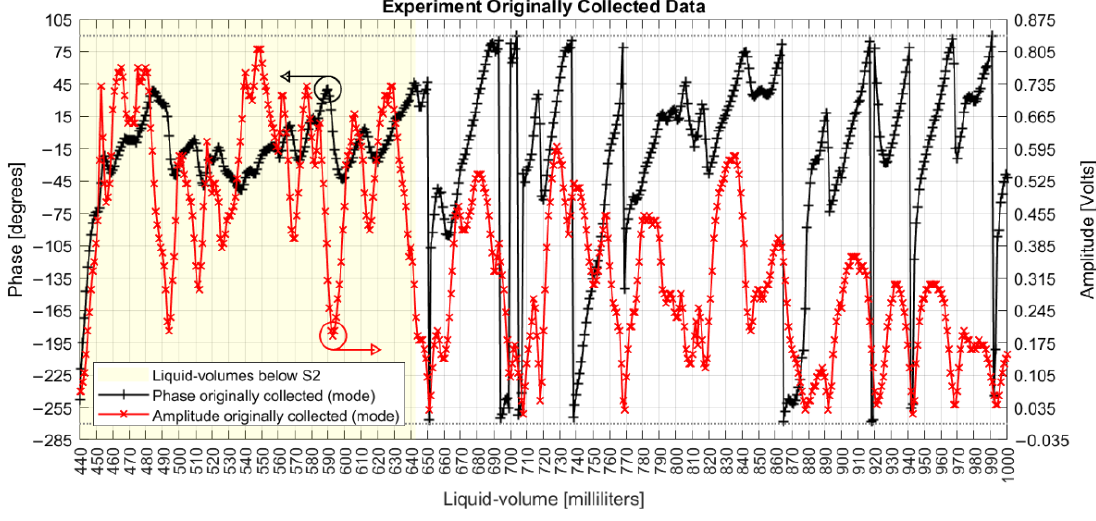
Figure 6. Original amplitude and phase mode values collected per milliliter.